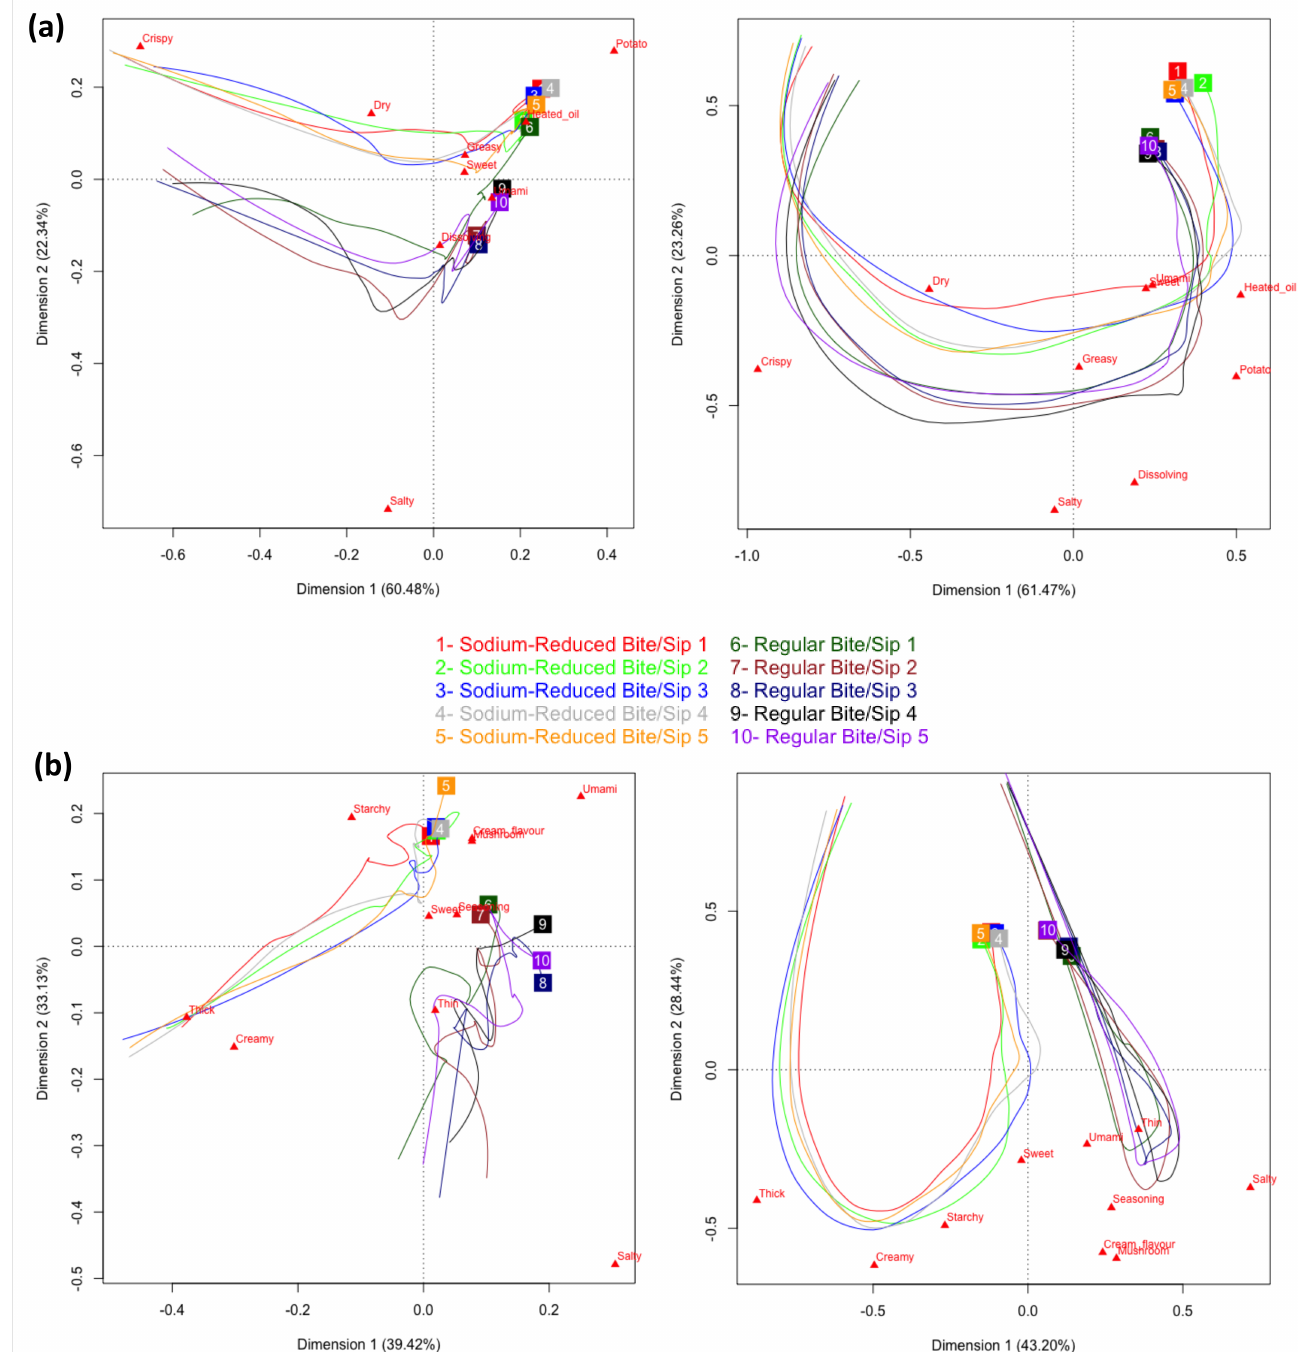
Figure 5. Product trajectories for Principal Component Analysis on time-standardized TDS (left) and TCATA (right) data for multi-intake evaluations of regular and sodium-reduced chips ( a ) and soup ( b ); labeled at the respective trajectory